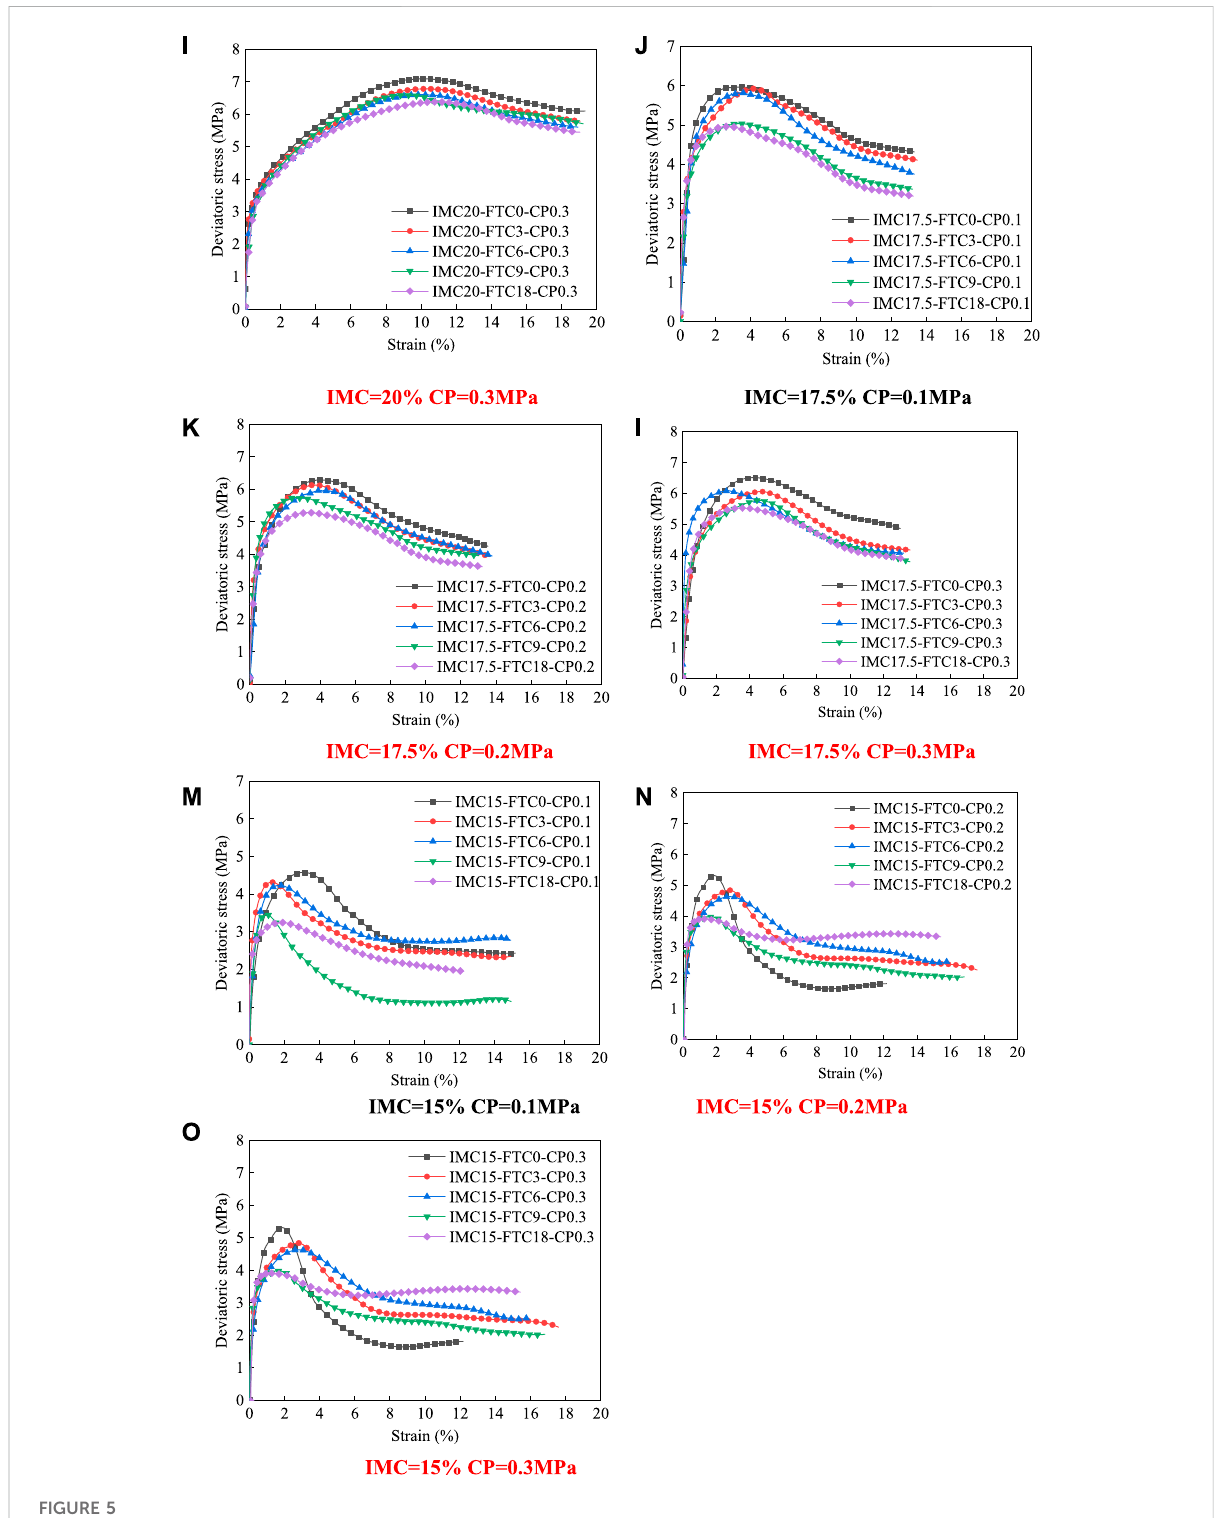
FIGURE 5 Stress-strain curves of frozen silty clay with different freeze-thaw